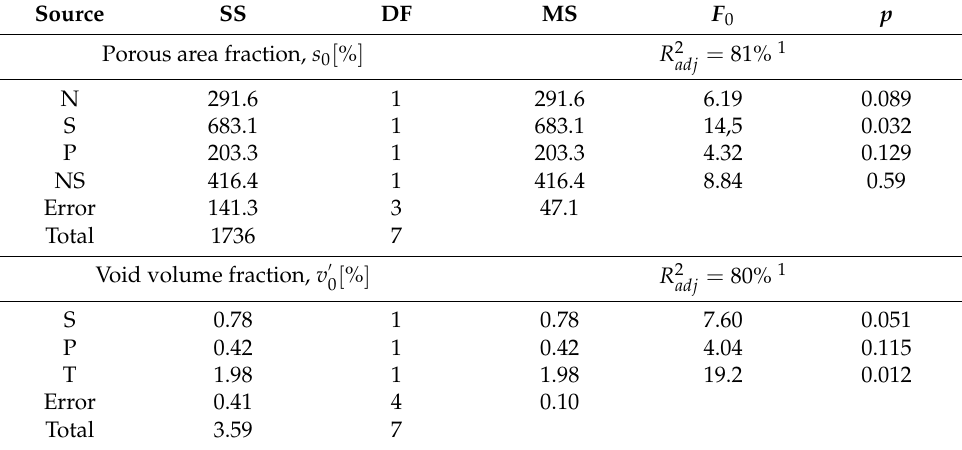
Table 3. ANOVA tables including Sum of Squares (SS); Degrees of Freedom (DF); Mean Squares (MS); F-statistic, F 0 , associated to each term; and level of significance, p , associated to each